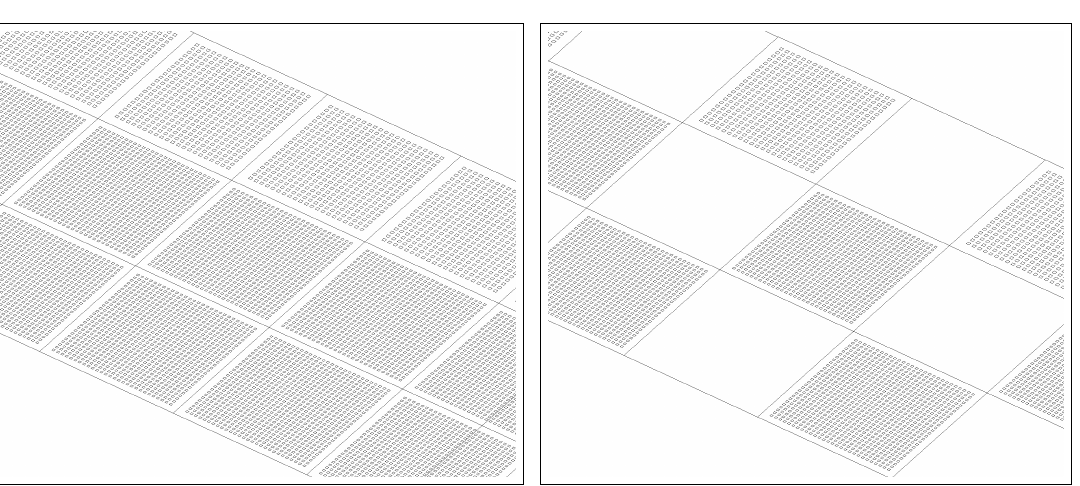
Figure 3. Full ceiling panel distribution (left) and chessboard panel distribution